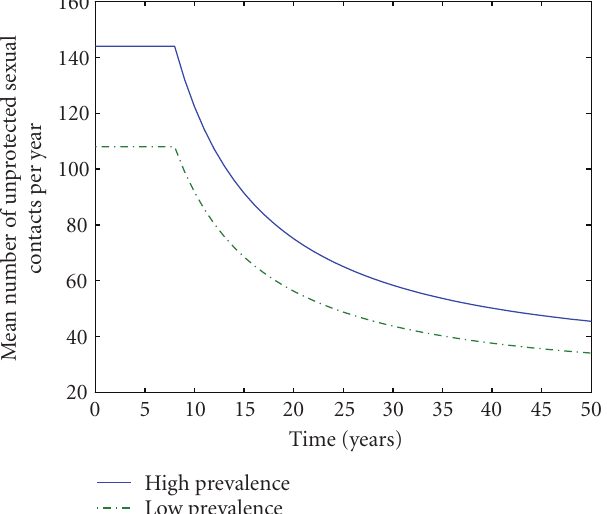
Figure 2.1 . Time trends in number of unprotected sexual contacts for high- and low-prevalence settings used for model projections.